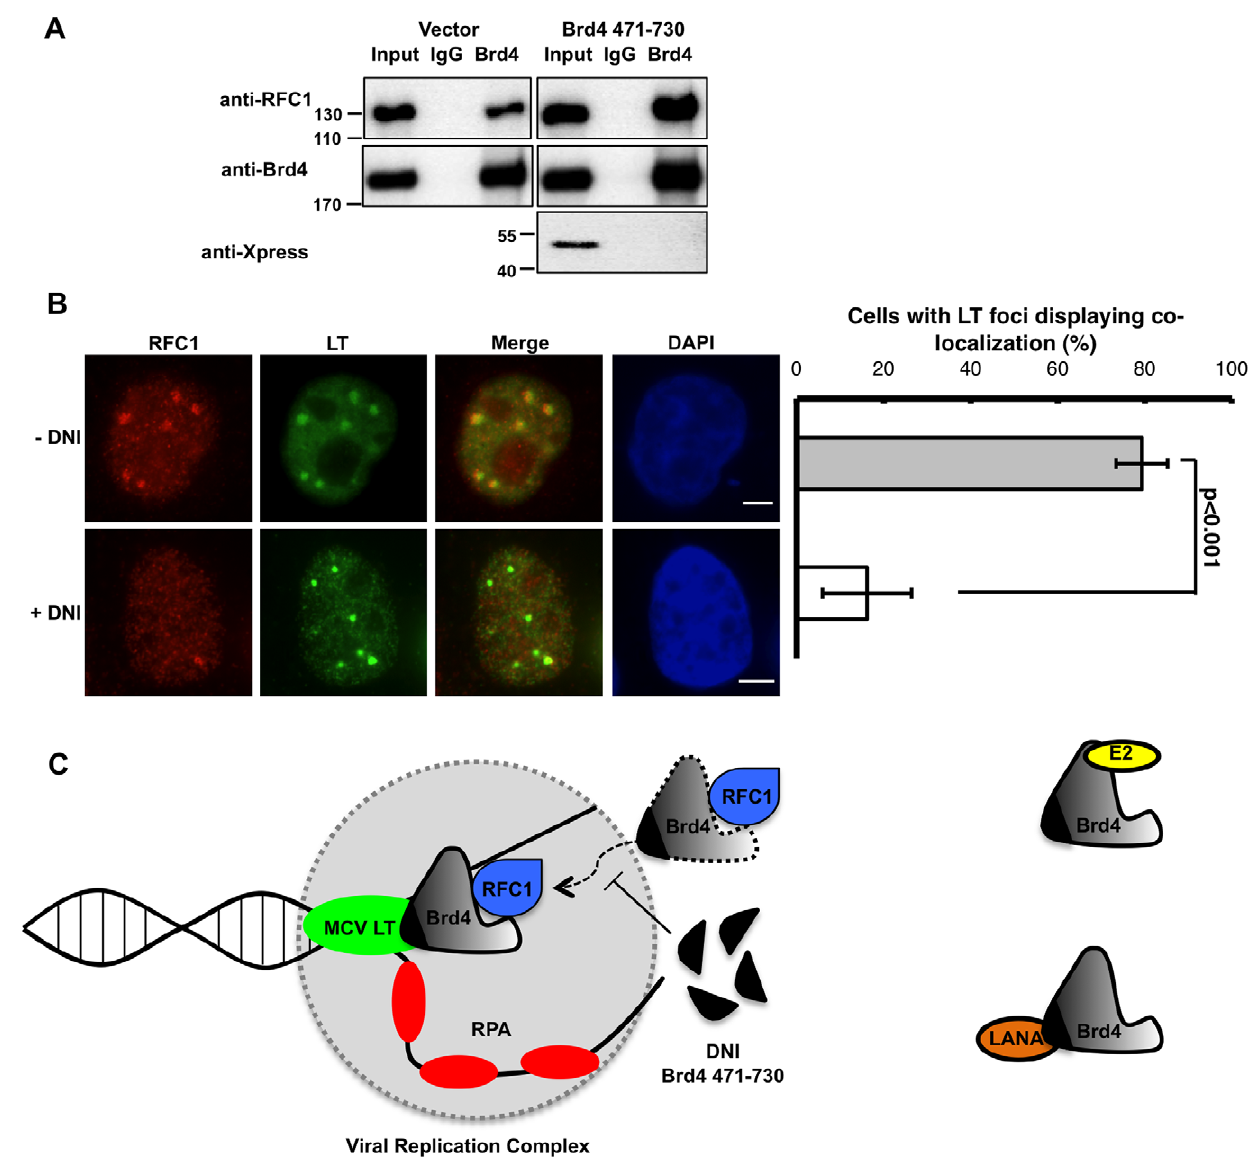
Figure 8. The DNI inhibits RFC1 recruitment to the viral replication complex. A . Brd4 interacts with RFC1 and this interaction is not affected by Brd4 471-730. 293T cells were co-transfected with an RFC1 expression plasmid and either a pCDNA4C plasmid encoding Xpress-tagged Brd4 471- 730 or the empty vector. Nuclear extracts IPed using either normal rabbit IgG or Brd4 CA were immunoblotted using antibodies against RFC1, Brd4 or the Xpress epitope tag. B . The DNI inhibits RFC1 and MCV LT co-localization. C33A cells were co-transfected with pcDNA4C-MCV LT and either pcDNA4C-MCV Ori ( 2 DNI) or pcDNA4C-MCV Ori-DNI ( + DNI). Cells were stained using antibodies for RFC1 (Red) and MCV LT (Green). Bar, 5 m m. Mean and standard deviation of the percentage of cells with LT foci displaying RFC1 and LT co-localization in punctate dots were calculated from three independent experiments. More than 100 cells were counted in each sample. C . A model for the Brd4-mediated MCV DNA replication. The Brd4-MCV LT interaction recruits RFC1 to the unwinding viral DNA to facilitate replication. The DNI blocks the Brd4 and MCV LT interaction and prevents the recruitment of RFC1 to the viral replication complex. The interactions between Brd4 and other viral proteins such as papillomavirus E2 and KSHV LANA are also